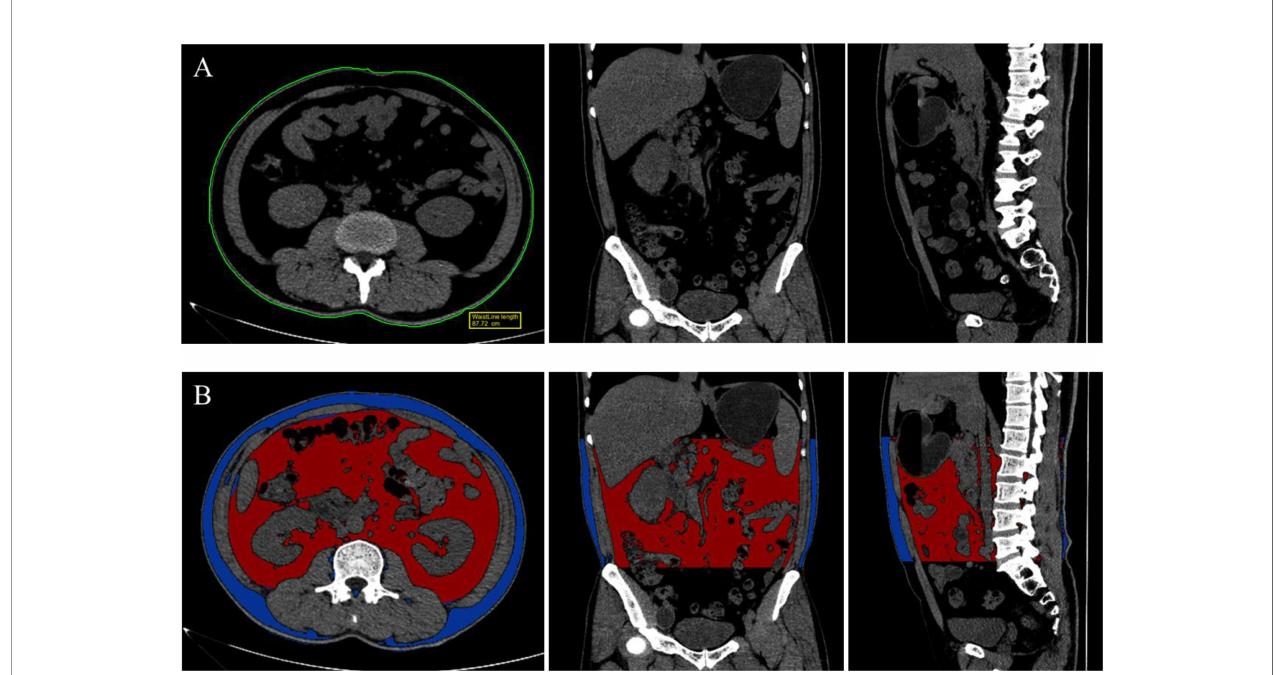
FIGURE 2 | Measurement of waist circumference (A) at the middle of the lower rib margin and the iliac crest and Segmentation of visceral adiposity tissue (B) , ranging from the upper pole of kidney and L5/S1 intervertebral disc, both achieved in Siemens Healthineers Syngo via Frontier application with multi-planar reformation (MPR)